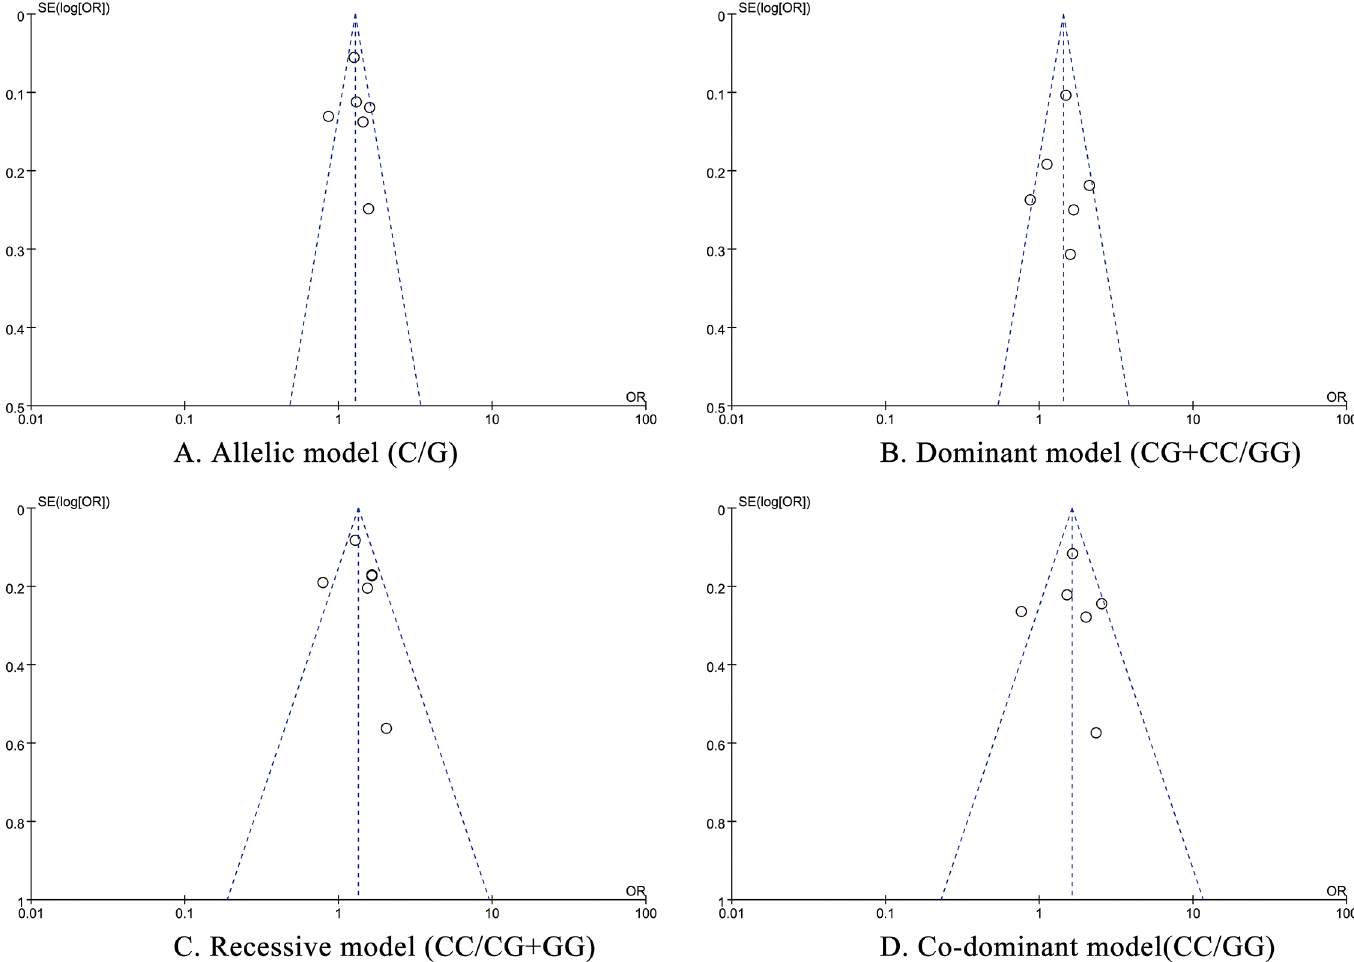
Fig 5. Funnel plot of the association between rs2296545 and risk of HT in the genetic